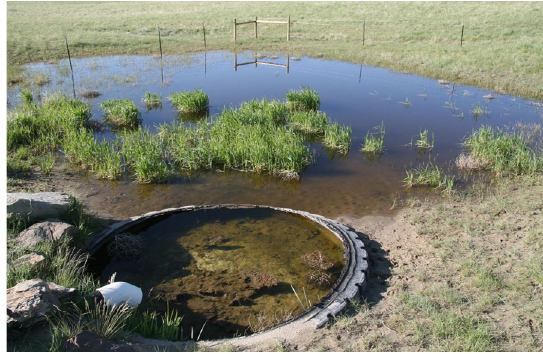
Fig. 14 Discharge and vegetation on reclaimed area (May 2002)